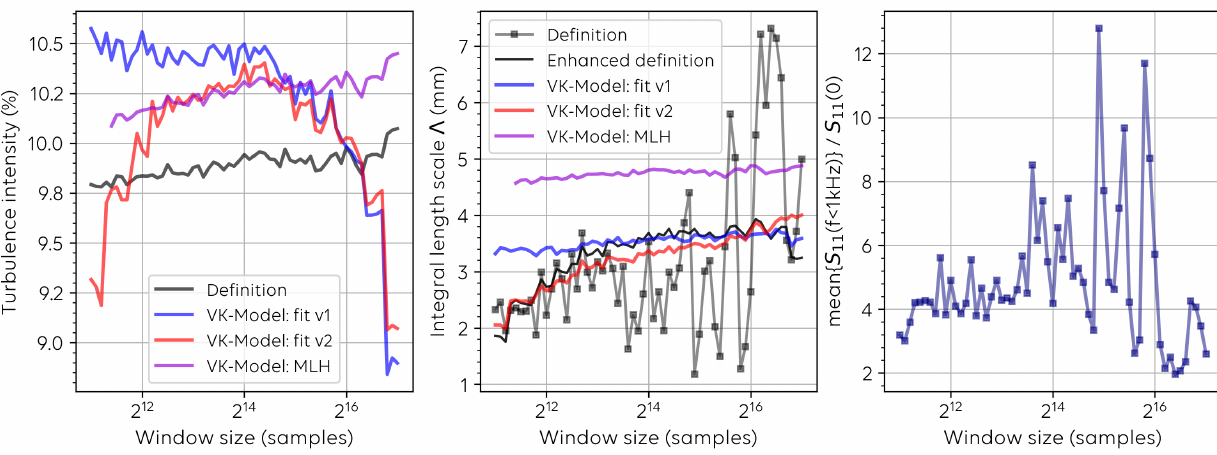
Figure 7. Impact of the window size on the results obtained for each turbulence parameter estimation technique using turbulence data from an LES simulation. For this illustration the longitudinal velocity component was